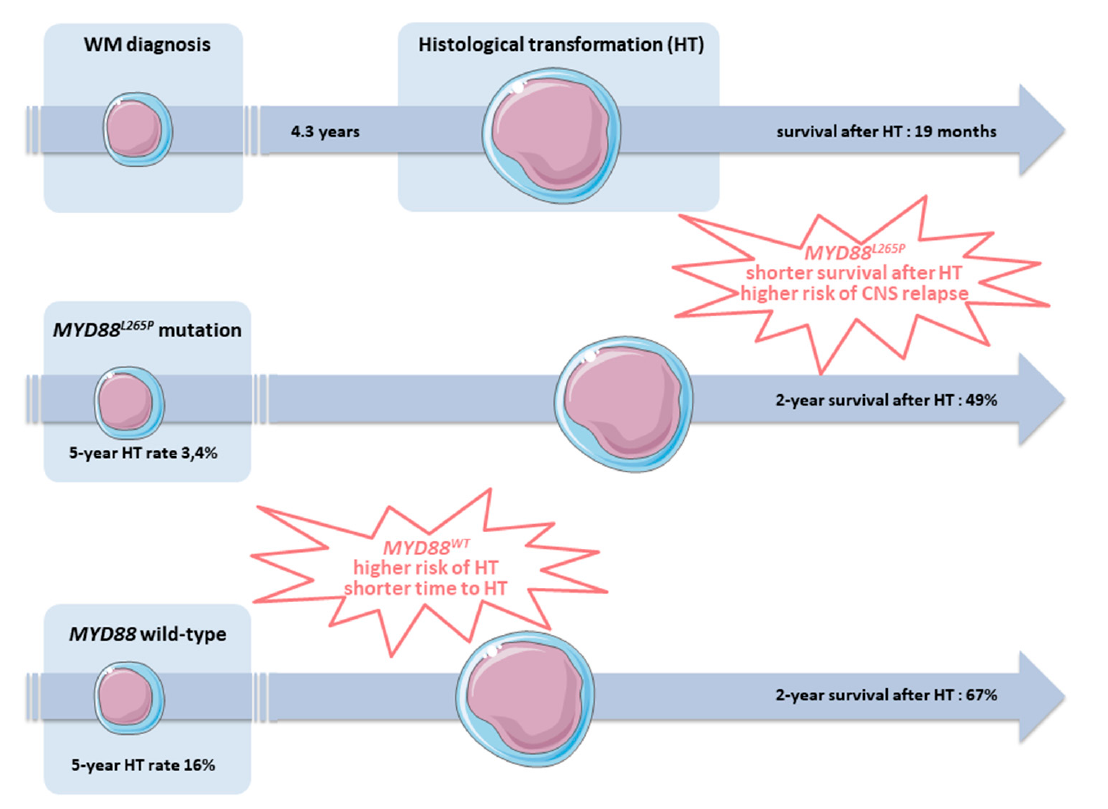
Figure 1. Schematic representation of HT in WM. Transformation rates, times to HT and survival